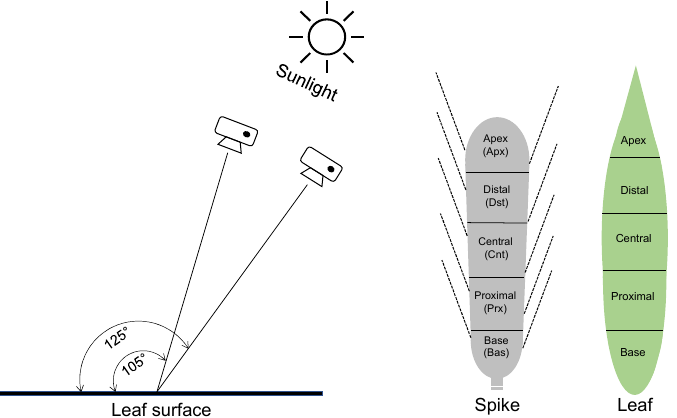
Figure 9. Conditions of hyperspectral image acquisition and separation of regions in leaf and spike for taking hyperspectral shooting.